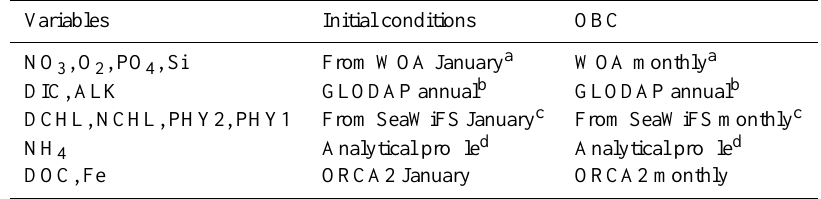
Table 1. Initial and open boundary conditions used for the INDO12BIO configuration.